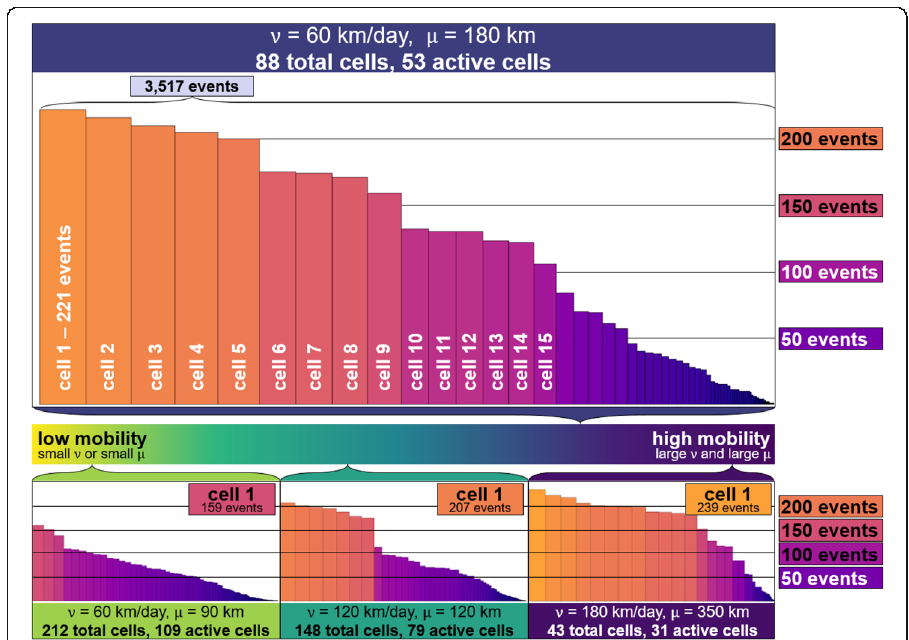
Fig. 5 Each one of the 3,517 Boko Haram events are assigned to a unique cell. For each subfigure, the horizontal axis represents the 3,517 events, grouped by their corresponding cell, sorted in decreasing order according to their number of events. Wider (and taller) bars represent cells with a higher number of